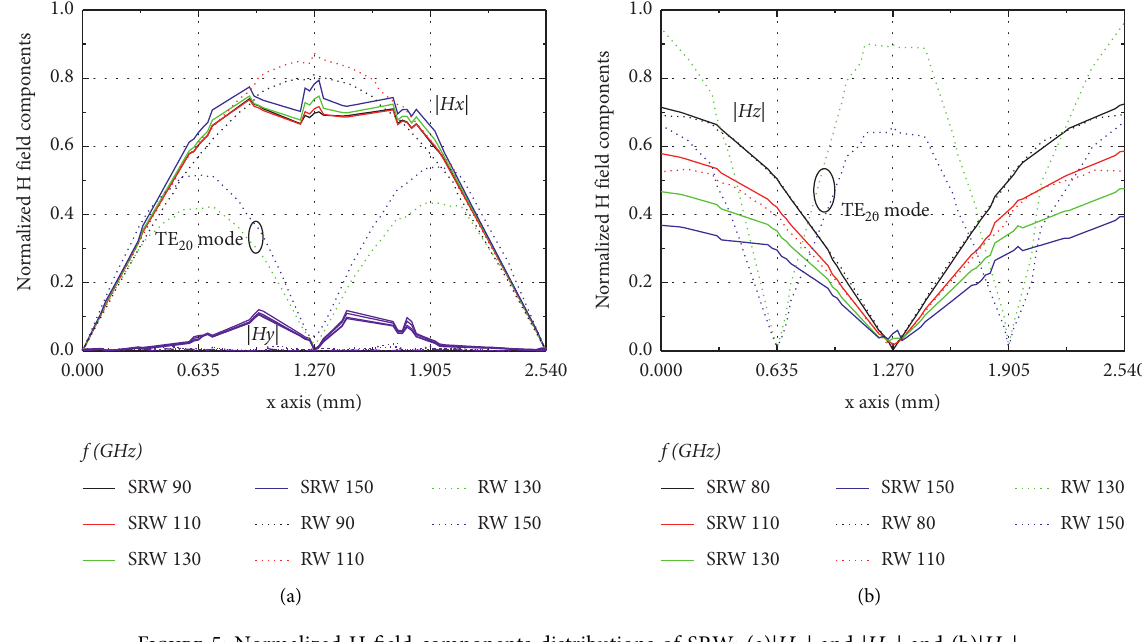
| and | H | and (b) | H | . x y z